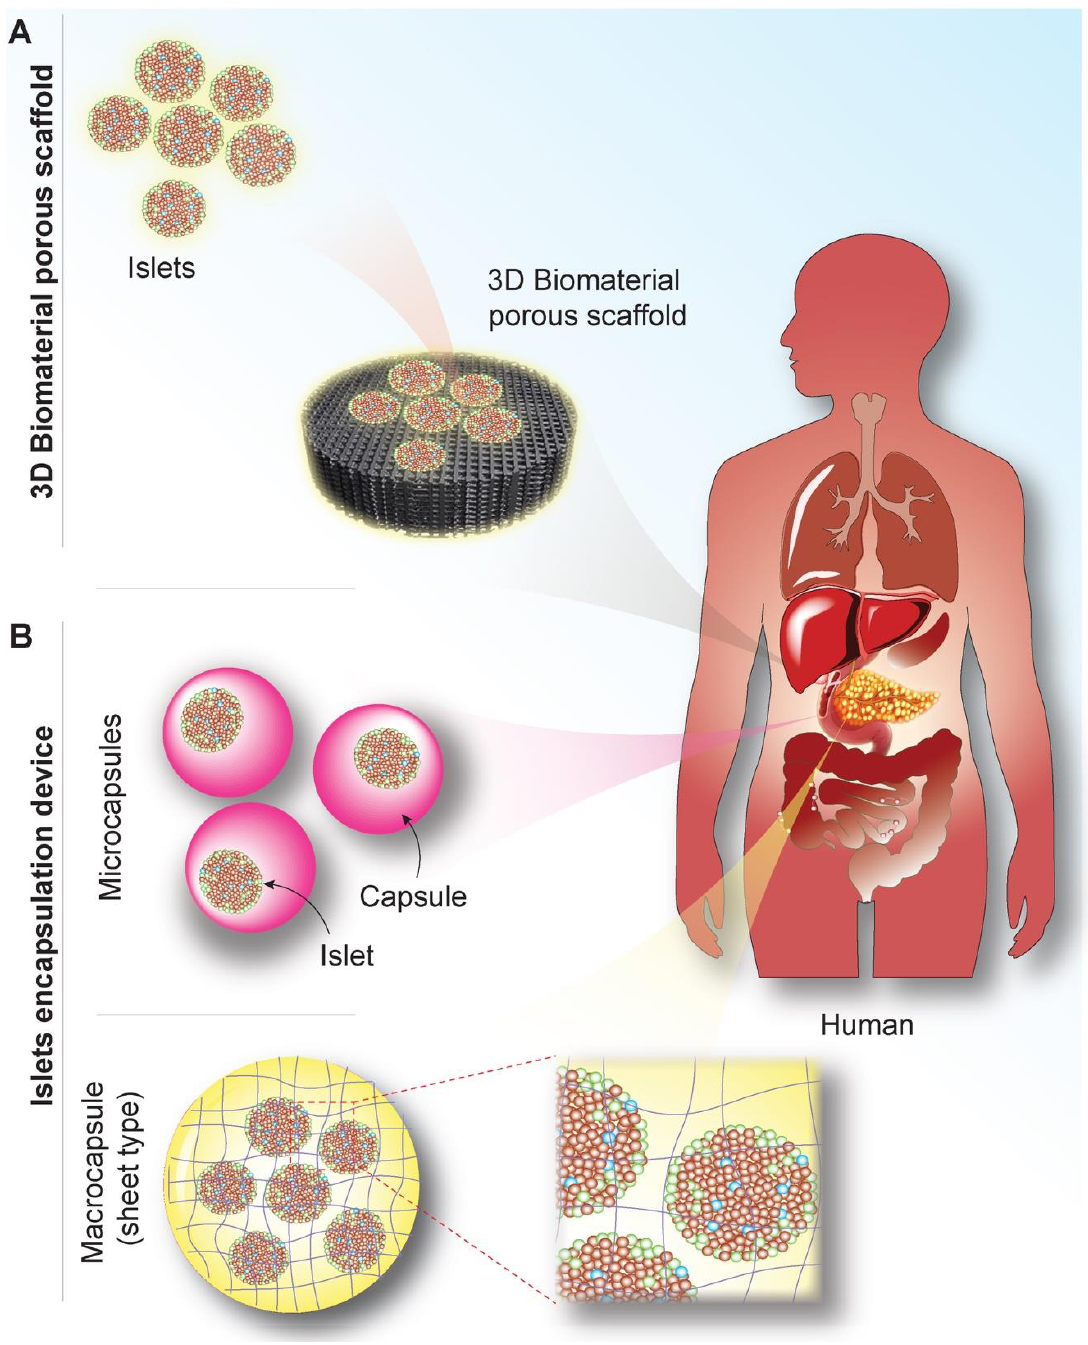
Figure 5. Schematic illustration of different approaches investigated for islet-based tissue engineering. ( A ) Three-dimensional (3D) porous polymeric bioscaffold designed to provide mechanical support for islets enabling transplantation at extrahepatic and extravascular sites. ( B ) Encapsulation systems, including micro- and microcapsules, able to prevent immune rejection of transplanted islets.